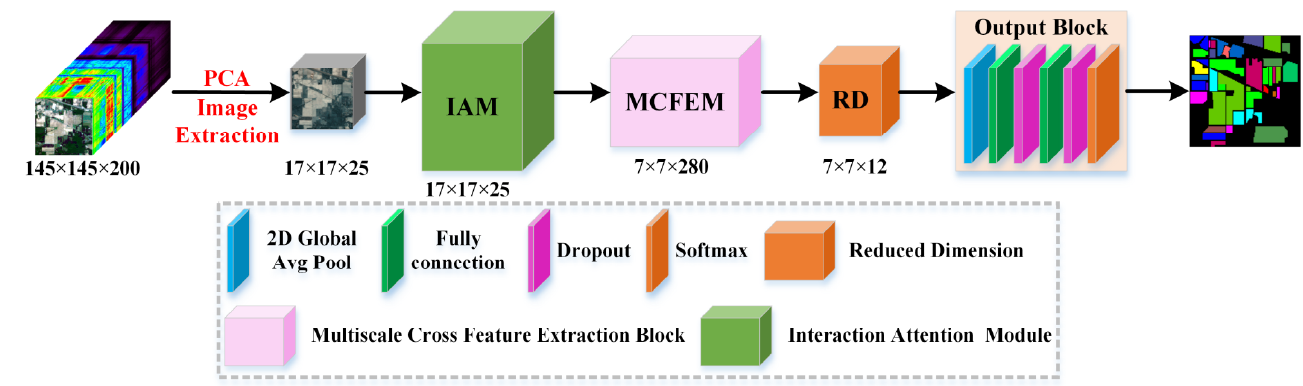
Figure 1. Architecture of the designed MCIANet model.